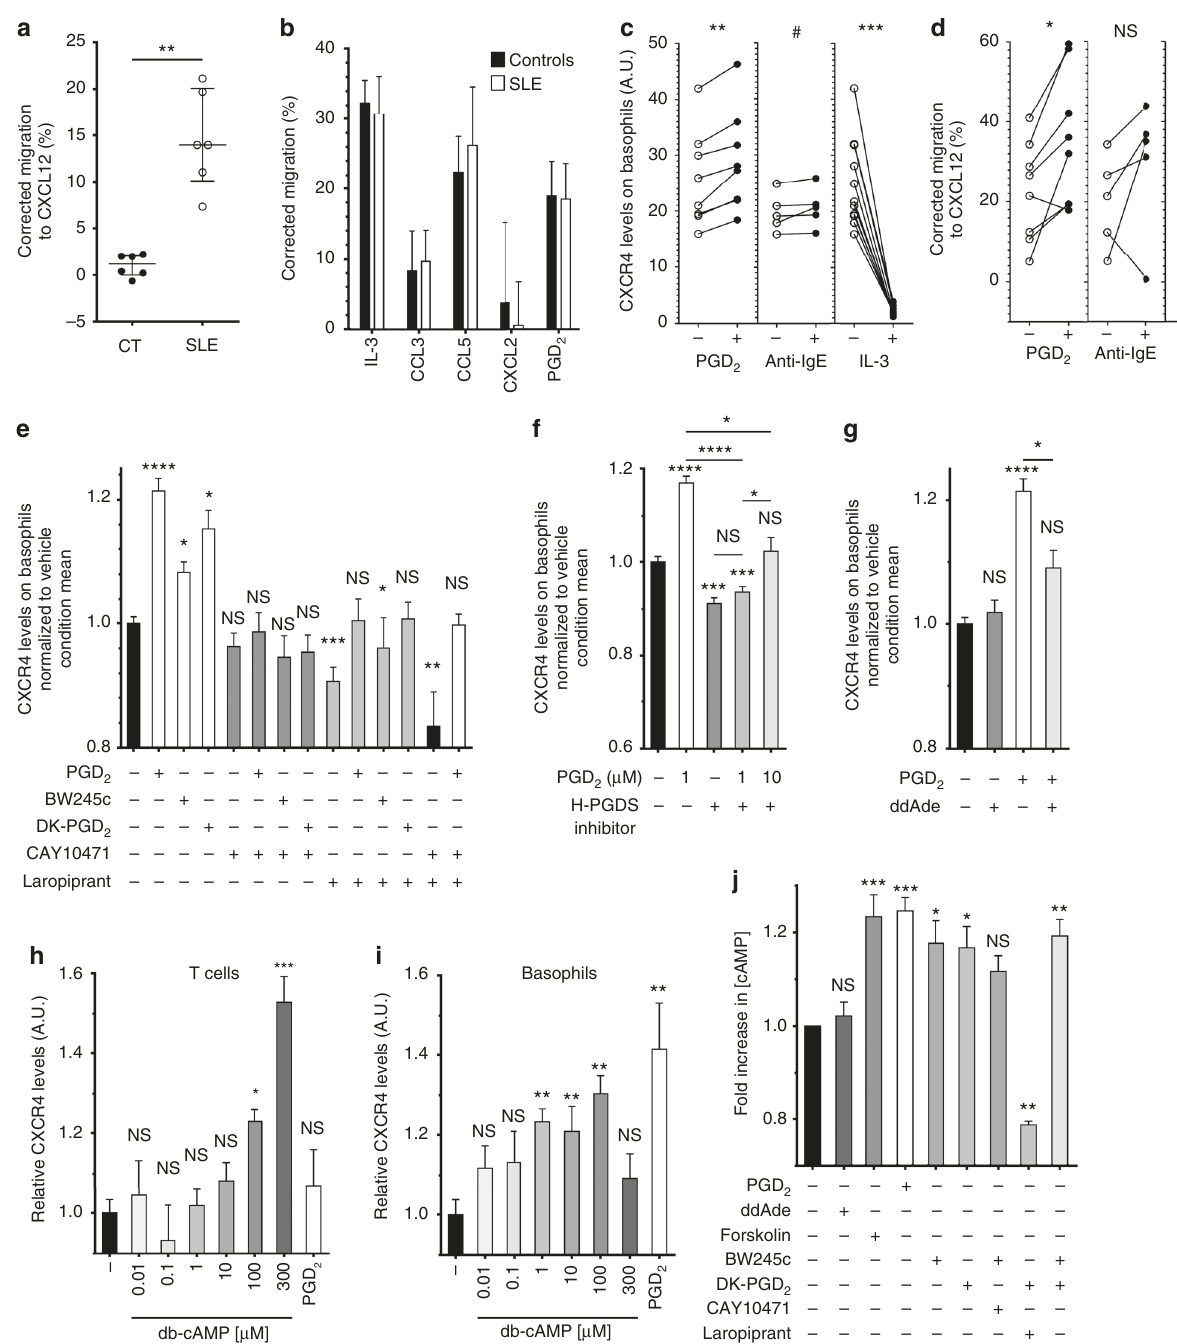
Fig. 3 CXCR4-dependent basophil migration is enabled by both PTGDR. a , b Migration assays of human blood basophils from CT ( n = 6) and active SLE patients ( n = 6) towards CXCL12 ( a ) and towards IL-3, CCL3, CCL5, CXCL2, and PGD 2 ( b ) from healthy controls (Controls, n = 8/4/3/4/7, respectively) and from SLE patients (SLE, n = 6/3/6/3/5, respectively). c , d FACS analysis of CXCR4 expression levels ( c ) and migration towards CXCL12 ( d ) of puri fi ed CT human blood basophils after 18 h of incubation without ( − ) or with (+) 1 µ M PGD 2 , anti-human IgE antibodies or IL-3. e , f , g CXCR4 expression levels were assessed as in ( c ) on puri fi ed human blood basophils after 4 h of incubation with 1 µ M of the indicated compounds (except for ddAde: 50 µ M) (PTGDR-1 agonist: BW245c, antagonist: Laropiprant; PTGDR-2 agonist: DK-PGD 2 , antagonist: CAY10471). Data are normalized to the mean value of the vehicle condition. For each condition, 3 − 12 independent experiments were conducted. h , i CXCR4 expression levels on mouse CD45 + CD3 + TCR β + T cells ( h ) and basophils ( i ) in splenocytes incubated 4 h without ( − ) or with the indicated concentration of db-cAMP or 1 µ M PGD 2 as determined by fl ow cytometry as described in Supplementary Fig. 1. j Fold increase in cAMP concentration in puri fi ed human basophils stimulated for 15 min with 1 µ M of the indicated compound (except for ddAde (50 µ M) and Forskolin (10 µ M)) normalized to the unstimulated condition (pool of six independent experiments). a Data are expressed as medians and interquartile ranges. b , e – j Data are presented as mean ± s.e.m. a – j Statistical analyses were by Mann − Whitney tests ( a , b ), paired Student t test ( c – i ) or by Tukey ’ s multiple comparisons test ( j ). a – j NS: not signi fi cant, # P = 0.06, * P < 0.05, ** P < 0.01, *** P < 0.001, **** P < 0.0001. Comparison to control group is shown above each bar and to the corresponding bars when indicated. A.U. arbitrary